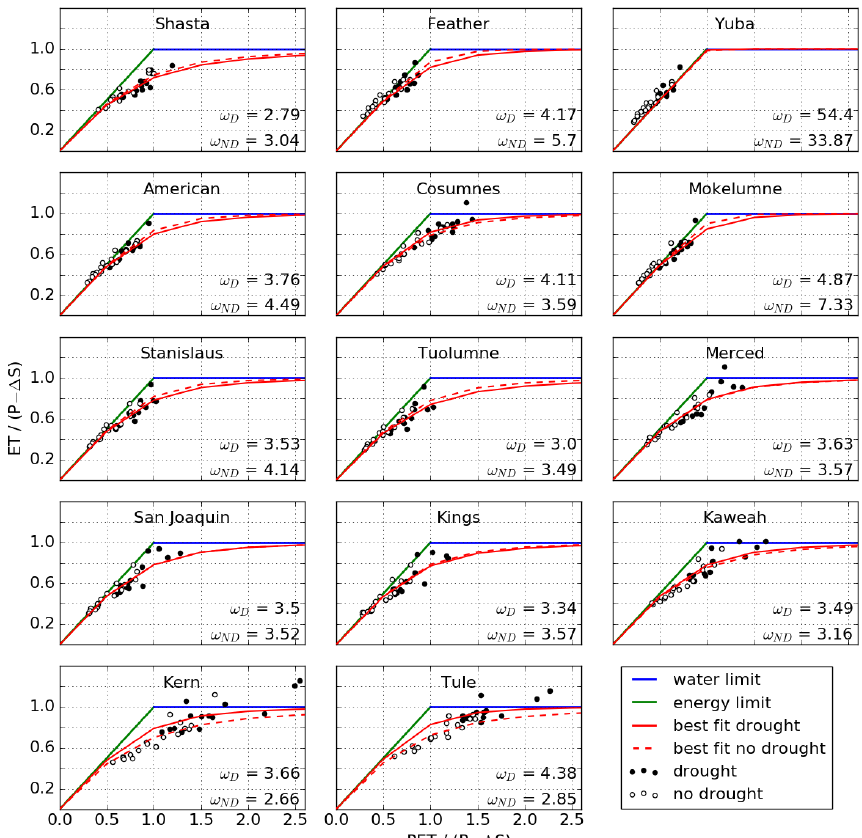
Figure 4. Annual (water year) water balances plotted in the extended Budyko framework, with calibrated best-fit lines for drought and non-drought periods. Values of ω are given for drought (D) and non-drought (ND) periods. Table 1. Change in evapotranspiration and runoff during drought attributable to regime and partitioning shifts.